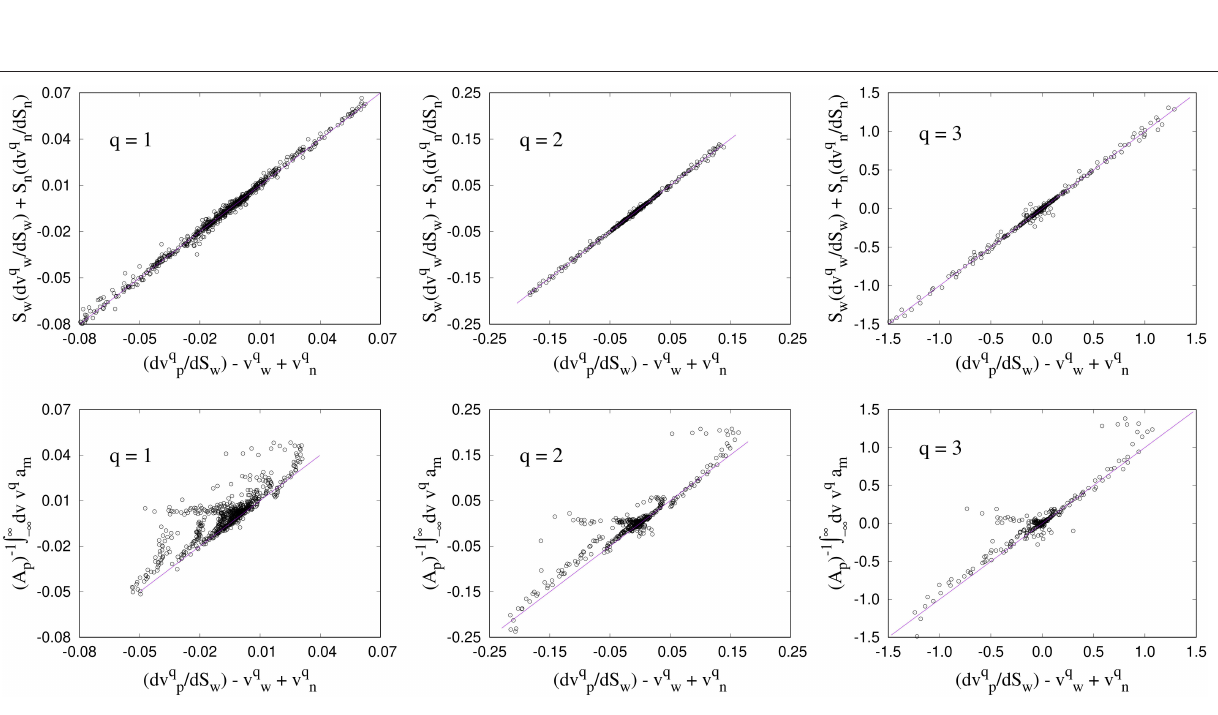
FIGURE 5 | Measurements of v q m for the 3D Berea network where the top row corresponds to the direct measurements using Equations (29) and (30), and the bottom row corresponds to the measurement from the differential area distributions using Equation (46). Here, larger fluctuations in the results calculated with the differential pore area are observed compared to the 2D network. v m has a unit mm/s. Subsequently, for q 2 and 3, the units for v q m will be mm 2 /s and mm 3 /s, respectively. =